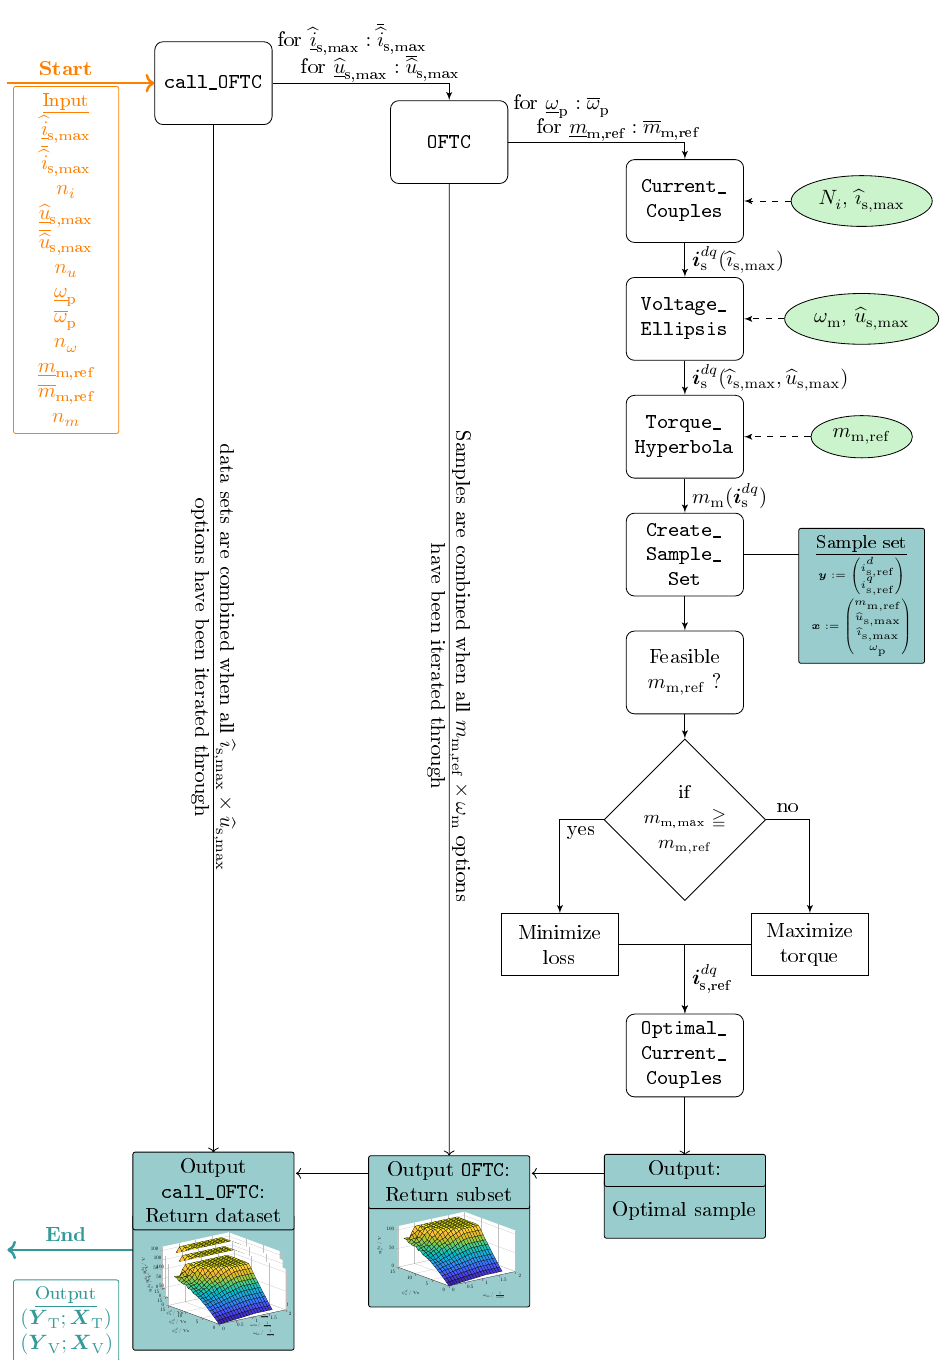
Figure 11. Software framework and workflow for data set creation: Outputs are the Training Set(s) ( Y ) and Validation Set(s) ( Y ) . T ; X T V ; X V The user has to provide the upper and lower bounds on current and voltage constraints, angular electrical velocity and reference torque (i.e., , m ) as inputs to the software framework. In addition, the user must specify the m m,ref m,ref desired resolution (number of data points) of the intervals (24)–(26) by n respectively. With this input data, the software framework starts the routine call_OFTC which will iteratively compute the optimal reference currents numerically based on the available measurement and/or FEA data and finally outputs training sets and validation sets for ANN training and validation,